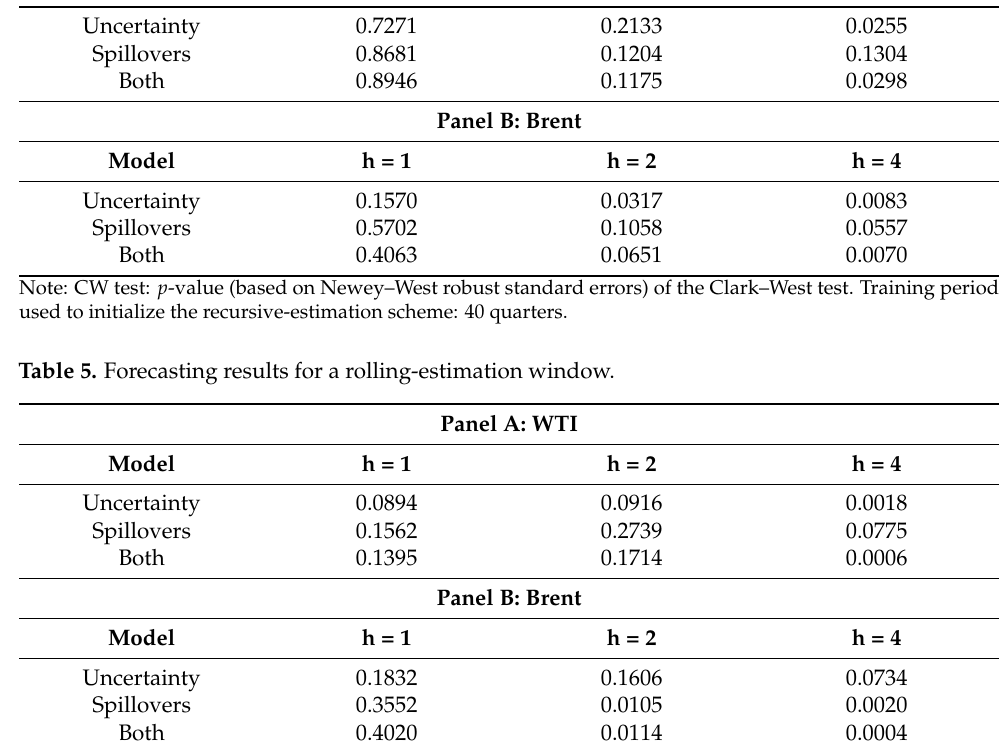
Table 4. Forecasting results for the realized volatility (